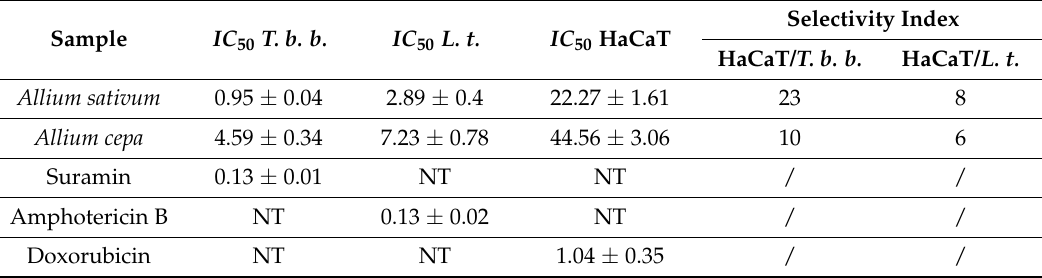
Figure 5. Dose-dependent trypanocidal, leishmanicidal and cytotoxic effects of ( a ) Allium sativum , ( b ) Allium cepa against Trypanosoma brucei brucei ( T. b. brucei ), Leishmania tarentolae ( L. tarentolae ) and human HaCaT cells. Data are expressed as mean of three individual experiments ± SD. Table 3. Trypanocidal, leishmanicidal and cytotoxic activity of Allium sativum and Allium cepa extracts against Trypanosoma brucei brucei ( T. b. b. ), Leishmania tarentolae ( L. t. ) and HaCaT cells. The values are expressed as mean IC 50 (μg/mL) ± SD; NT: not tested.